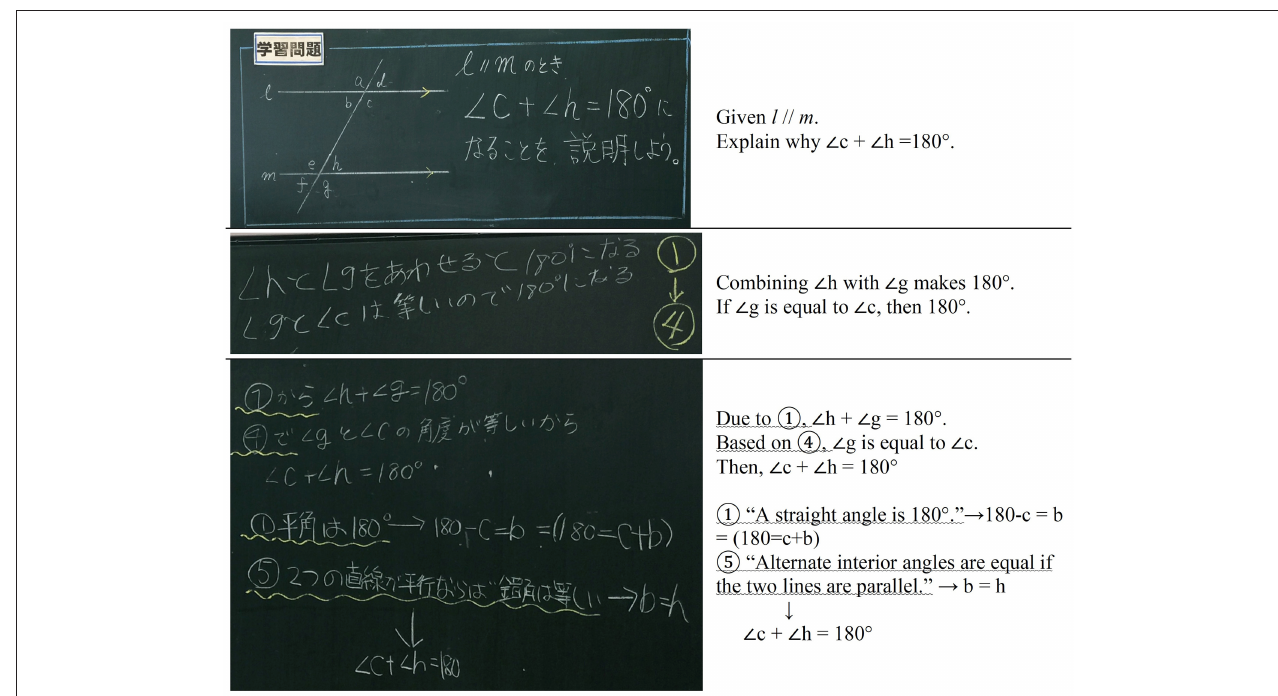
FIGURE 5 | Problem and students’ explanations with the teacher’s comments in yellow